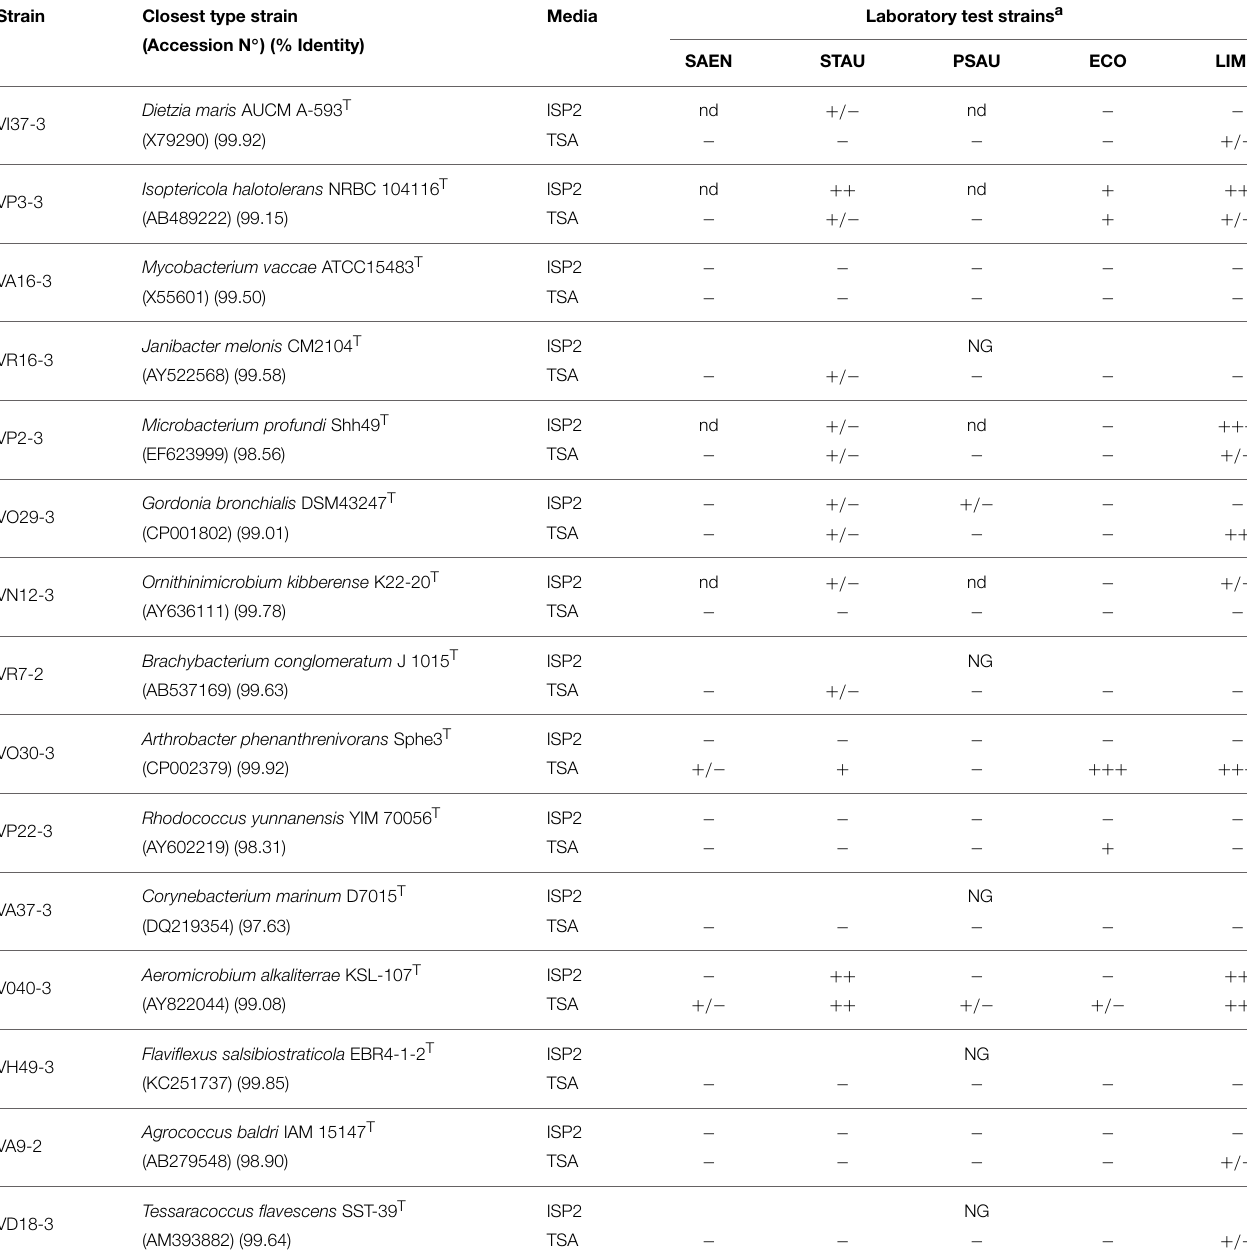
TABLE 2 | Antimicrobial activity of non streptomycete-like strains. Strain Closest type